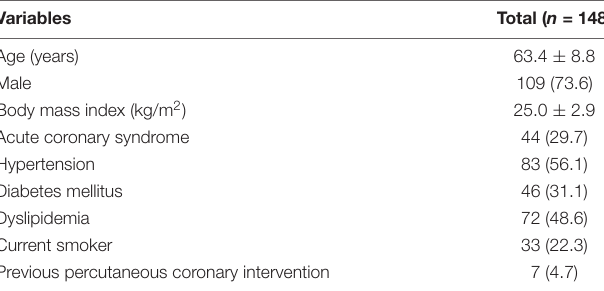
TABLE 1 | Baseline clinical